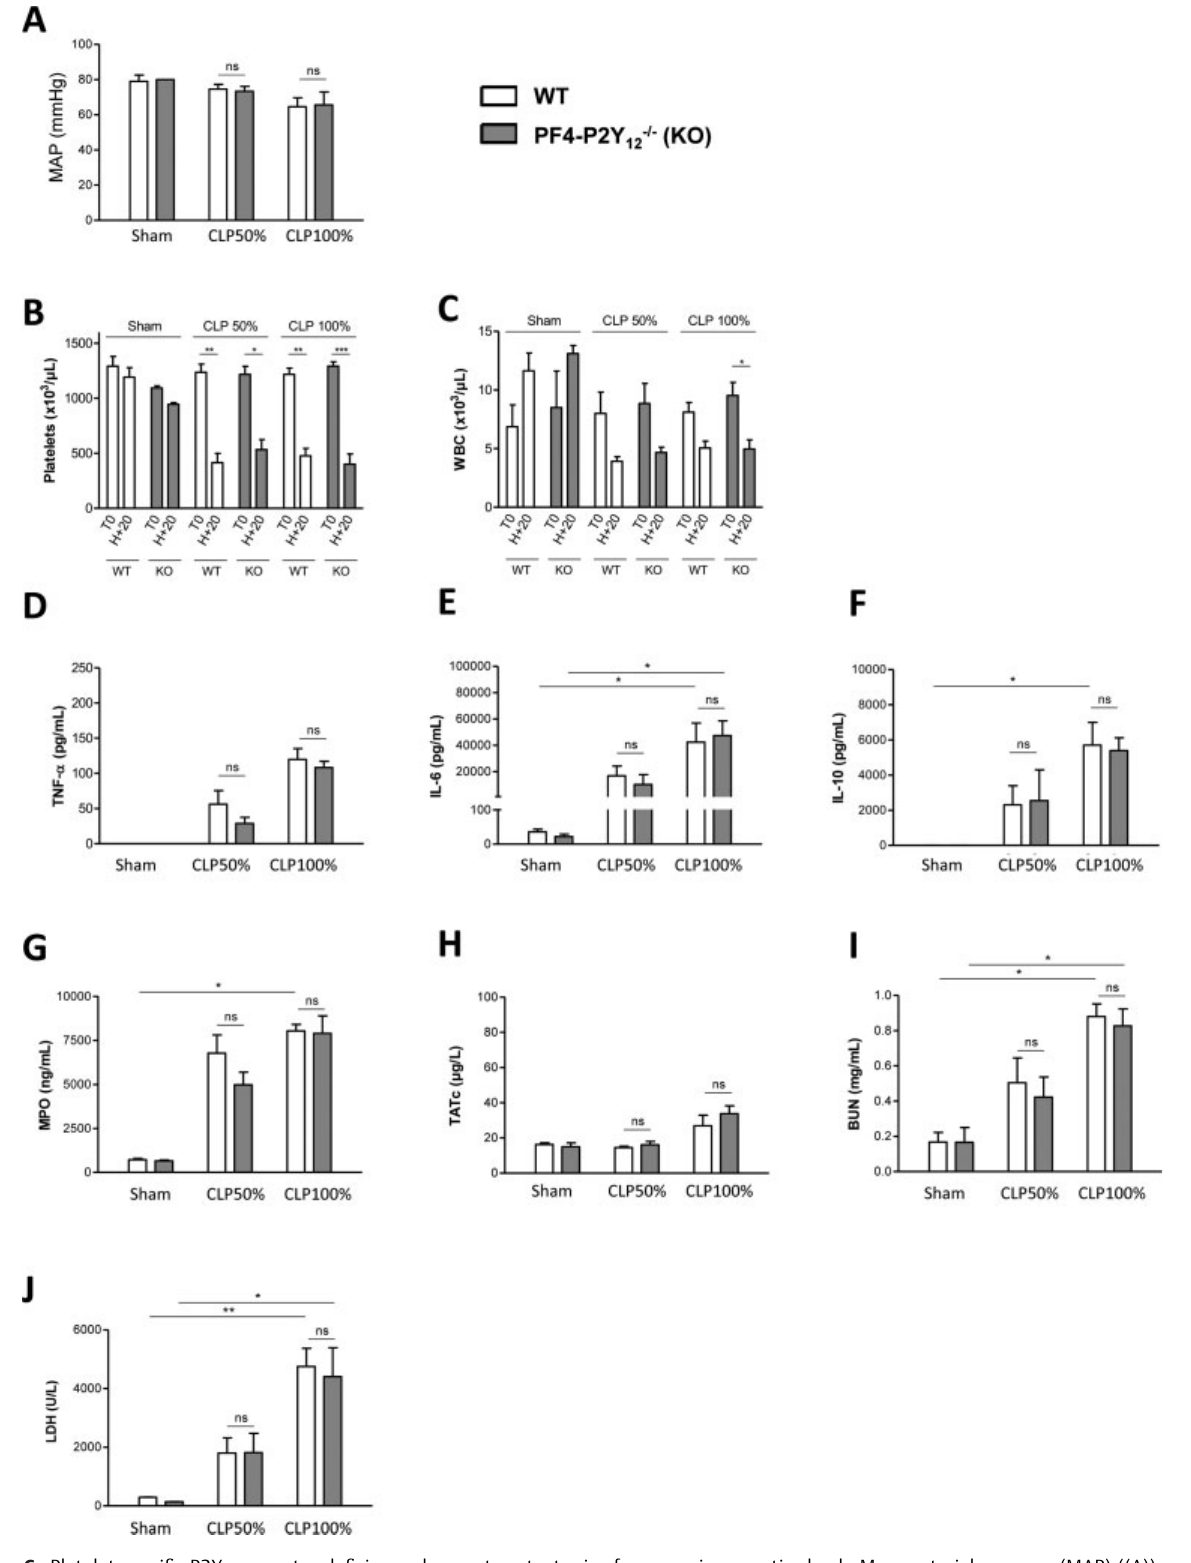
Fig. 6 Platelet-speci fi c P2Y 12 receptor de fi ciency does not protect mice from sepsis or septic shock. Mean arterial pressure (MAP) ((A)), circulating platelet counts ((B)), WBC counts ((C)), plasma levels of TNF- α ((D)), IL-6 ((E)), IL-10 ((F)), myeloperoxidase (MPO) ((G)), thrombin- antithrombin complex (TATc) ((H)), blood urea-nitrogen (BUN) ((I)), lactate dehydrogenase (LDH) ((J)), in WT or PF4-P2Y 12 (cid:3) / (cid:3) mice (KO), 20hours after mid- or high-grade form of CLP as compared with sham-surgery. Results are presented as the mean (cid:4) SEM ( n ¼ 6 – 9, (cid:1)(cid:1)(cid:1) p < 0.001, (cid:1)(cid:1) p < 0.01, (cid:1) p < 0.05, ns p > 0.05).